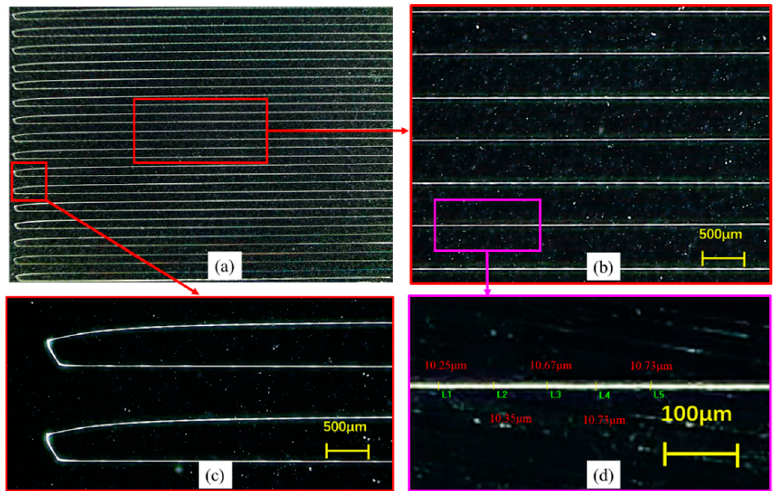
Figure 13. Deposition Single Layer Linear Grid. ( a ) the deposited single layer linear grid structure; ( b ) an enlarged view of the middle area; ( c ) an enlarged view of the selected right-angle area; ( d ) five position points were selected for deposition line as observation points for line width measure- ment.